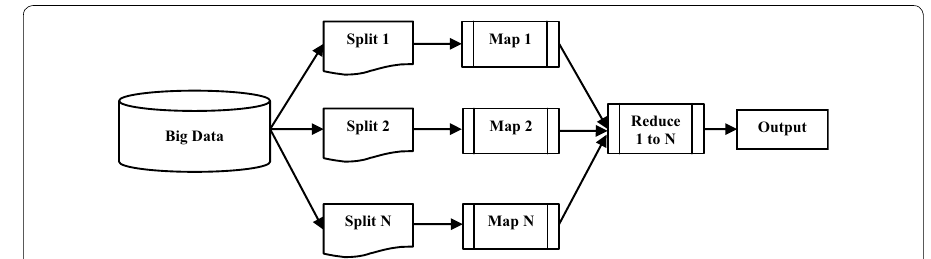
Fig. 2 Schematic diagram for processing big data using Map and